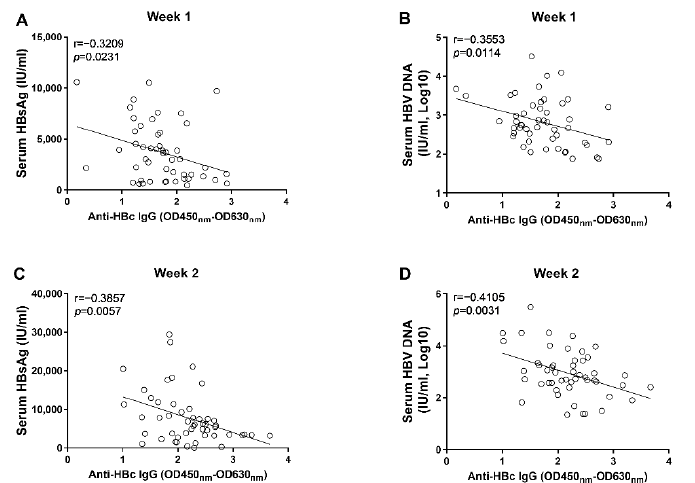
Figure 4. The correlation analyses between anti-HBc IgG responses and markers of HBV replication at the early phase of HBV infection; ( A ) the correlation between levels of anti-HBc IgG and concentrations of serum HBsAg at 1 wpi; ( B ) the correlation between levels of anti-HBc IgG and concentrations of serum HBV DNA at 1 wpi; ( C ) the correlation between levels of anti-HBc IgG and concentrations of serum HBsAg at 2 wpi; ( D ) the correlation between levels of anti-HBc IgG and concentrations of serum HBV DNA at 2 wpi. Statistical analysis was performed by the method of Pearson correlation ( n = 50).